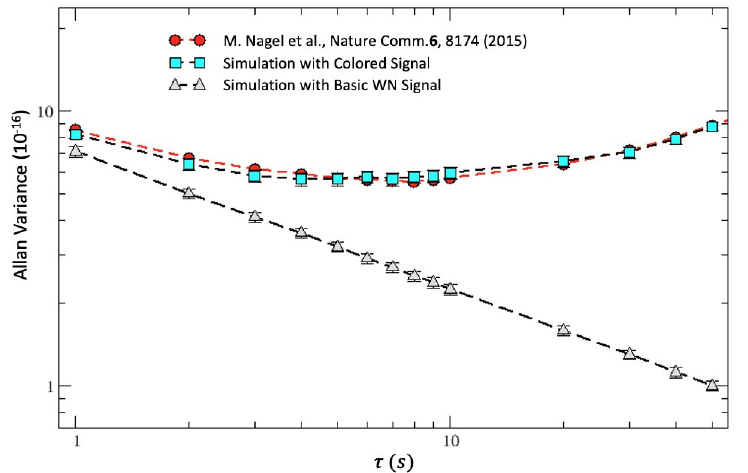
Figure 8. We report the Allan variance for the fractional frequency shift obtained from many simula- tions of sequences of 2000 s for our basic white-noise (WN) signal and for its colored version; see Figure 7. The direct experimental results of ref. [57], for the non-rotating setup, are also shown. The figure is taken from ref.